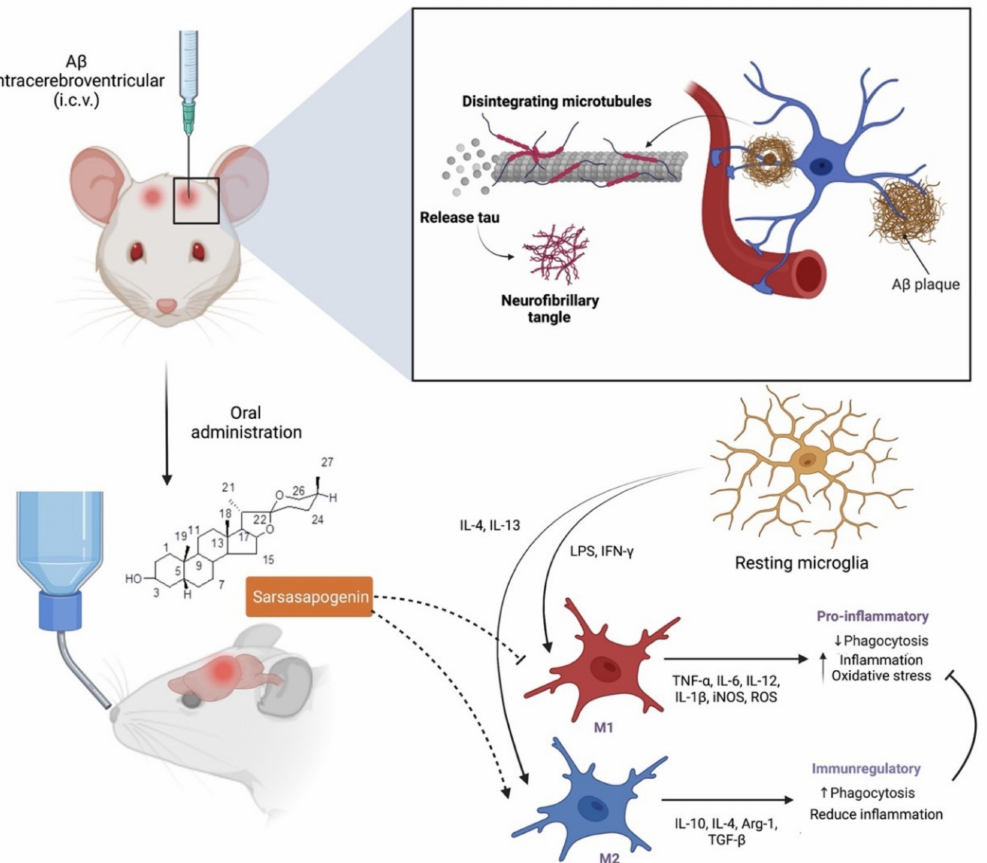
Figure 5. Neuroprotection effect of sarsasapogenin. Sarsasapogenin may suppress the expression of pro-inflammatory M1 markers while elevating the expression of anti-inflammatory M2 biomarkers when taken orally. M2 promotes to the additional inhibition of the M1 marker, hence, assisting in the protection of neuroglial cells. IFN- γ , interferon gamma; iNOS, nitric oxide synthase; ROS, reactive oxygen species; Arg-1, arginase 1; TGF- β , transforming growth factor